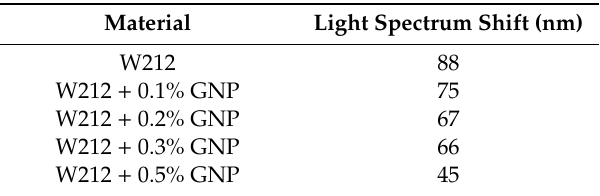
Table 2. A blue shift registered for PLCF samples infiltrated with W212 FLC at di ff erent concentrations of GNPs.